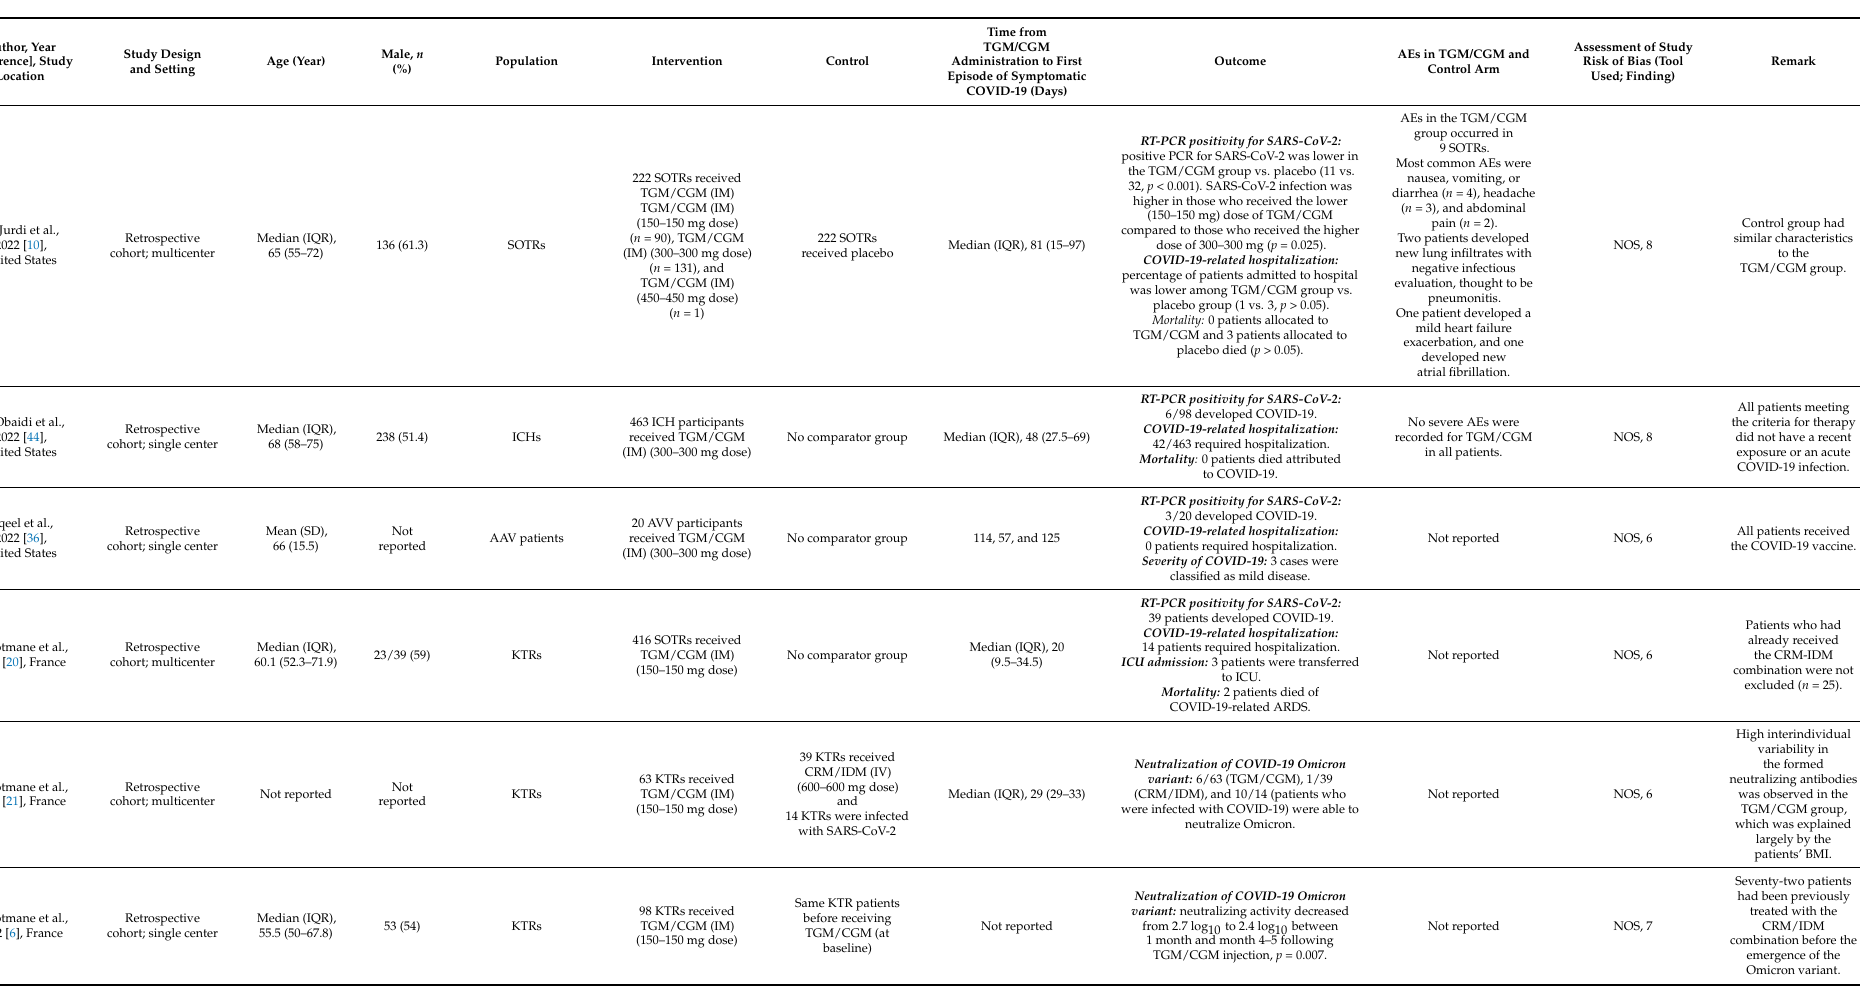
Table 1. Data extracted from included papers ( n =